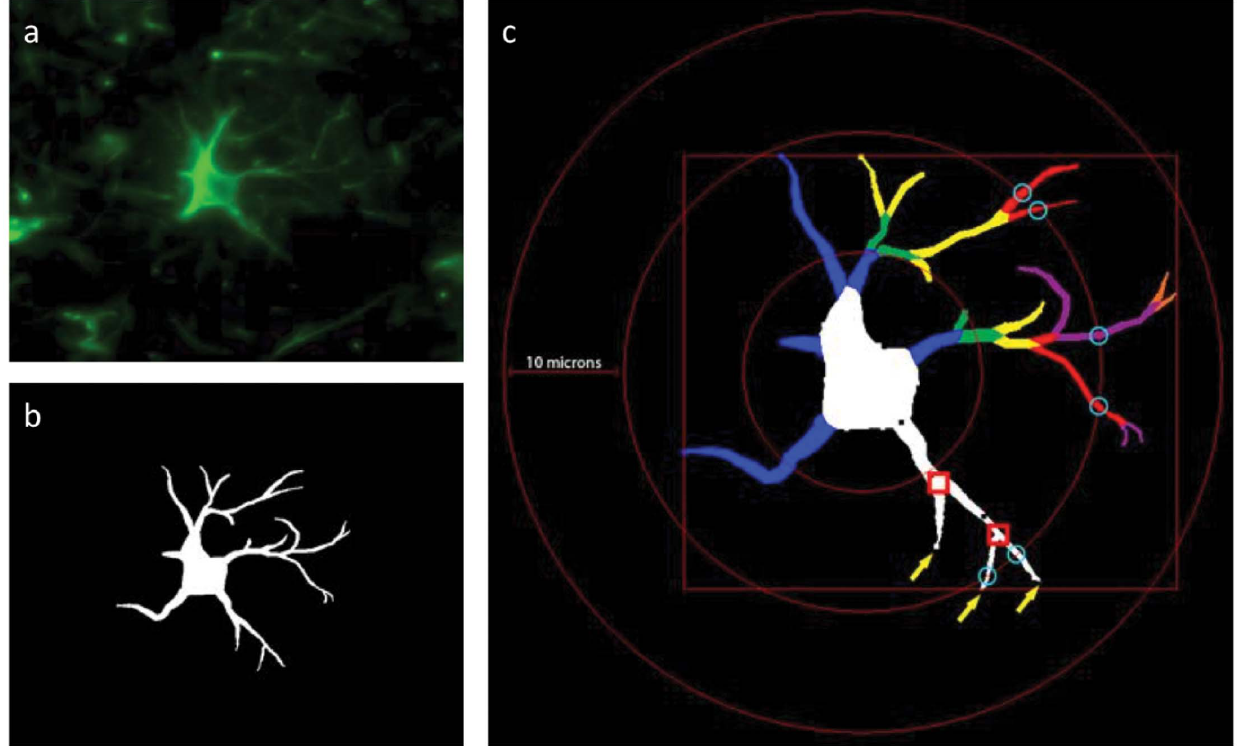
Figure 1. Schematic of Astrocyte Morphometrics Measured. Astrocytes, stained with GFAP were imaged using a fluorescent microscope (a). The image was then traced using the software (b) and the following morphological (c) parameters analyzed: cell body area (white), number of processes/dendrites, total arbor length (combined linear length), arbor volume (volume of 3D frusta), the number of nodes and the number of process